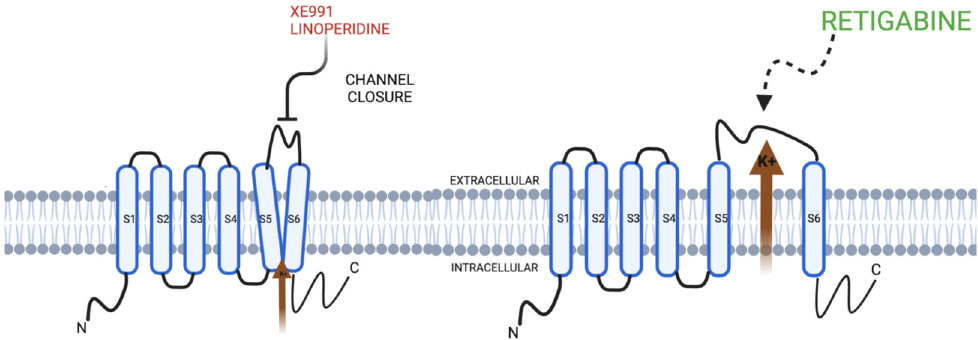
Figure 2. KCNQ channels and pharmacotherapeutic modulators in relation to the cellular mem- brane. Retigabine acts to open the KCNQ channel, whereas linopirdine and XE991 are channel in- hibitors that act to inactivate the KCNQ channel